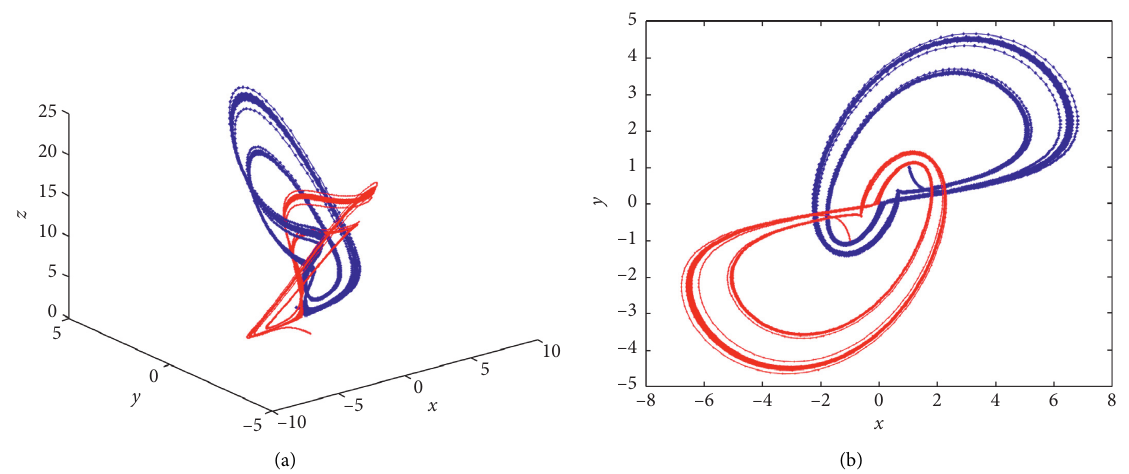
Figure 26: Coexisting attractors in ( x, y, z ) and ( x,y ) planes at α � 0 .